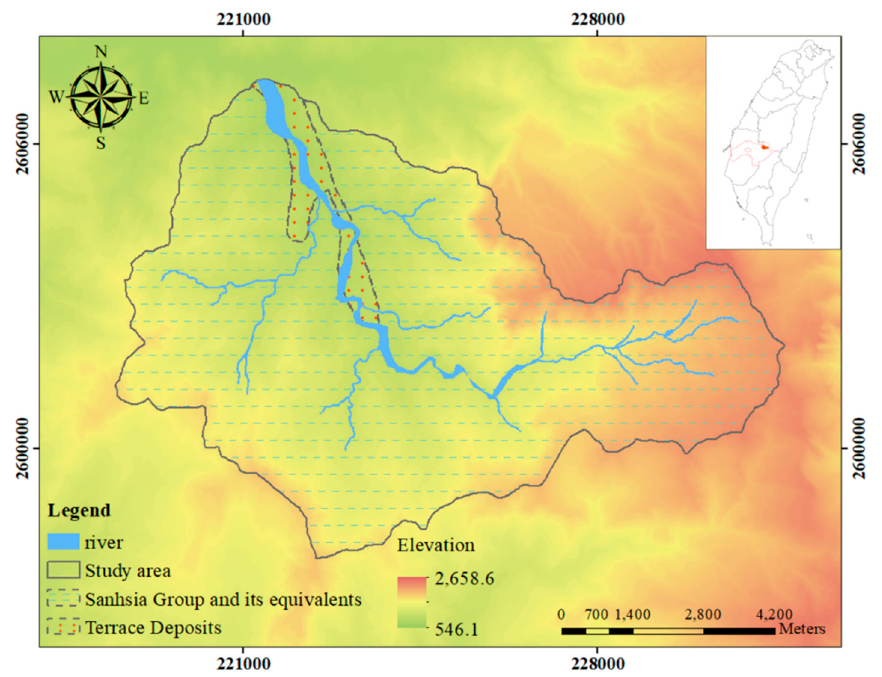
Figure 2. Location of study area in the upstream area of the Alishan River.